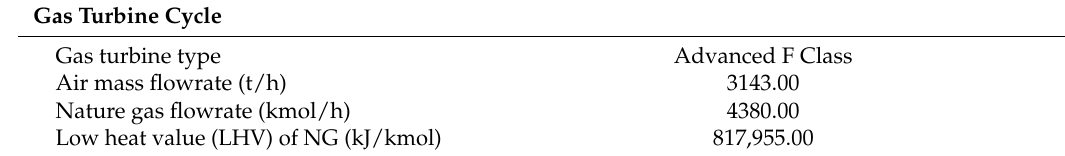
Table 1. Main parameters for the case